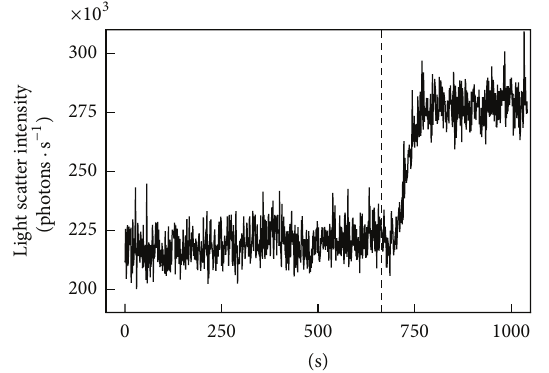
Figure 3: Ionomycin-stimulated microparticle release requires calcium-activated potassium current. Cells were washed and sus- pended in normal MBSS (“Iono alone” or “Raji”) or in MBSS that contained EGTA (2mM) instead of calcium, high potassium (83 mM KCl with equivalent reduction in NaCl), or quinine (1mM) at 37 ∘ C. The normalized light scatter intensity was calculated by subtracting the average initial intensity immediately prior to iono- mycin addition (20 points) from the average intensity at the plateau after ionomycin (about 350 s later; see Figure 2). This difference was then divided by the average initial intensity to standardize among trials. Differences in the normalized intensity among groups were significant by one-way analysis of variance ( 𝑃 = 0.0004 , 𝑛 = 2 – 9 per group). A posttest (Dunnett’s) revealed that the group of S49 cells treated with normal MBSS was distinguishable from each of the other four ( 𝑃 < 0.05